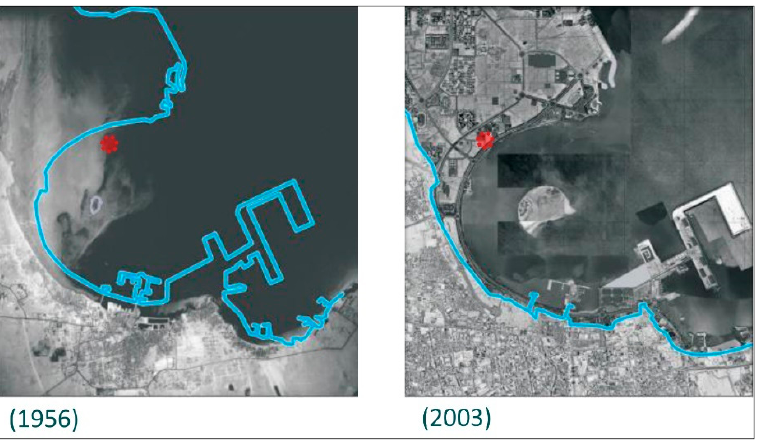
Figure 6. The Doha waterline in 1956 and 2003 (Source: Wiedmann, F., et al. Adapted from [29]).